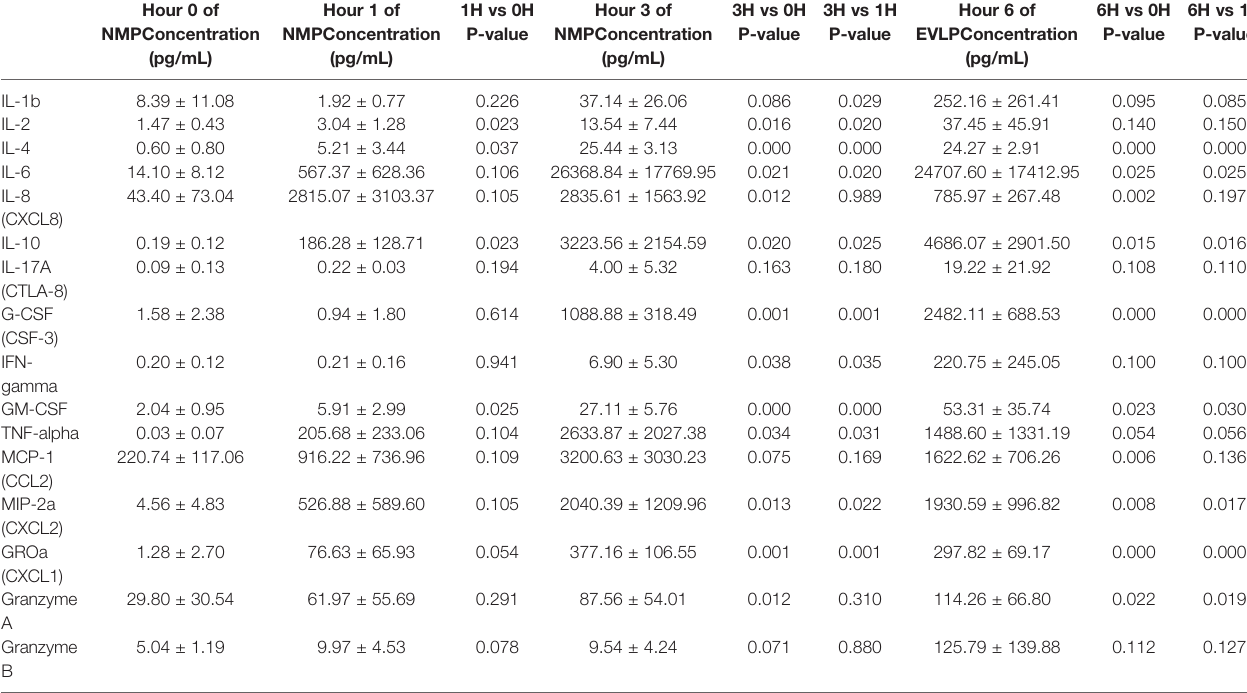
TABLE 2 | Cytokine concentrations (pg/mL) in human livers during 6 hour of normothermic machine perfusion. Hour 0 of